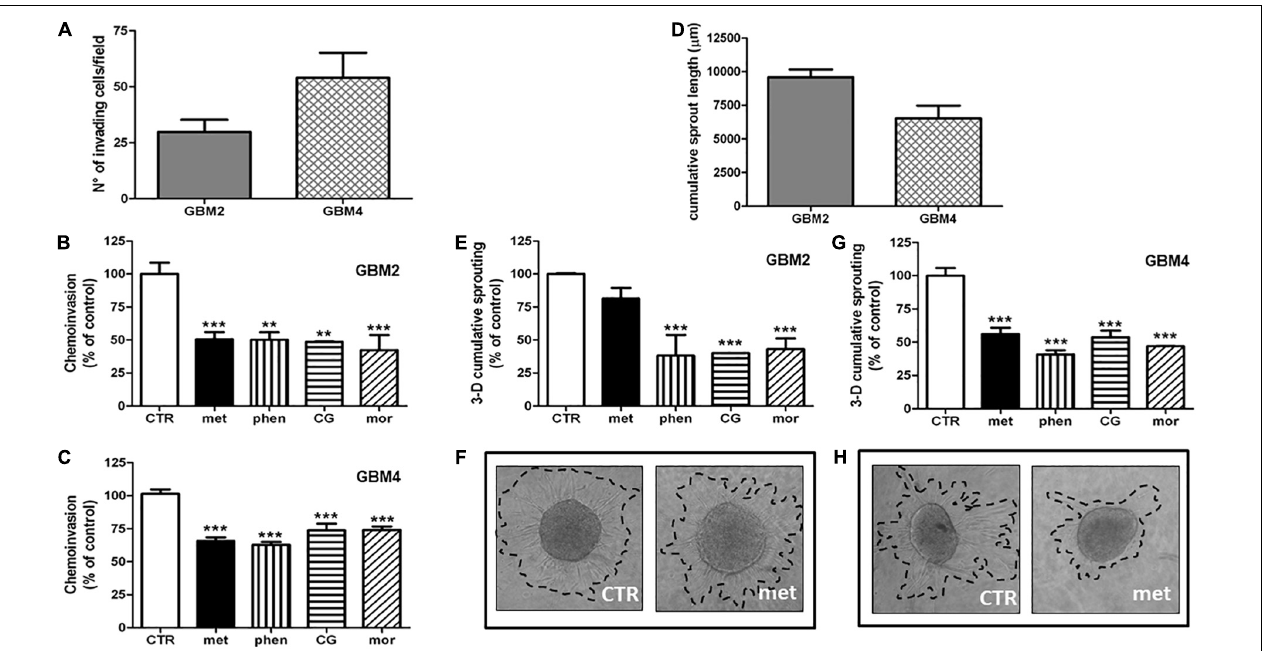
FIGURE 5 | Biguanides inhibit glioblastoma stem cells invasiveness. (A) Basal GSC invasiveness was tested by measuring the number of invading GBM2 and GBM4 cells in chemo-invasion assays. Invading GBM2 (B) and GBM4 (C) cells were quantified in the absence (CTR) or in the presence of metformin (met, 10 mM), phenformin (phen, 500 µ M), cycloguanil (CG, 100 µ M) or moroxydine (mor, 1 mM). Data are expressed as the percent of the number of invading control cells (CTR) set at 100%. ∗∗ p < 0.01, ∗∗∗ p < 0.001 vs. CTR, n = 3. One-way ANOVA followed by Bonferroni’s post hoc test. (D) Cumulative length of invading sprouts emerging from spheroids obtained from GBM2 or GBM4 cells were quantified after 24 h of incubation as described in the “Materials and Methods” section. Cumulative length of invading sprouts emerging from GBM2 (E) and GBM4 (G) spheroids were quantified after 24 h of incubation in the absence (CTR) or in the presence of metformin (met, 10 mM), phenformin (phen, 500 µ M), cycloguanil (CG, 100 µ M), or moroxydine (mor, 1 mM). Data are expressed as the percent of the cumulative sprouting measured in control spheroids (CTR) set as 100%. ∗∗∗ p < 0.001 vs. CTR, n = 3. One-way ANOVA followed by Bonferroni’s post hoc test. Representative images of GSCs sprouting outside the spheroids from control or metformin-treated GBM2 and GBM4 CSCs are shown in (F,H) , respectively, while representative images following the treatment with the other biguanides are reported in the Supplementary Figure S2